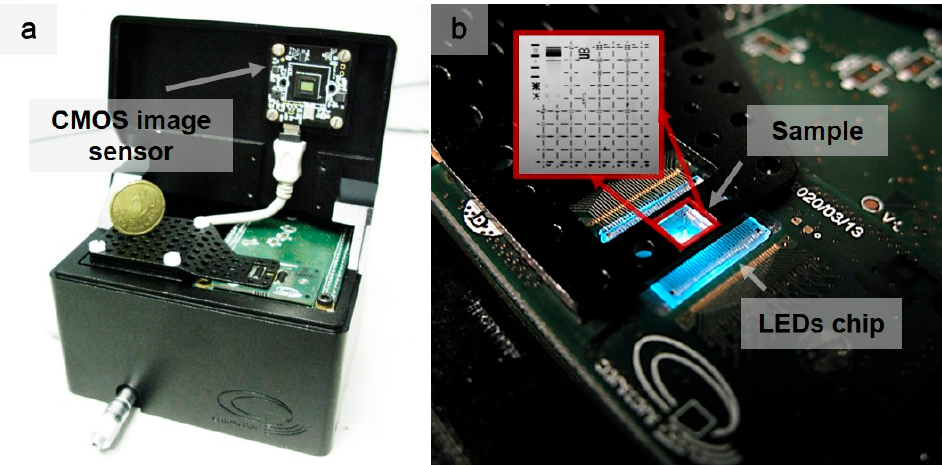
Figure 7. ( a ) Prototype of the mechanical-based microscope in comparison with a 20-cent coin. ( b ) Placement of the sample on the LED array for scanning with the mechanical-based STOM microscope. The operating LED had a size of 200 nm and emitted at a wavelength of 465 nm.